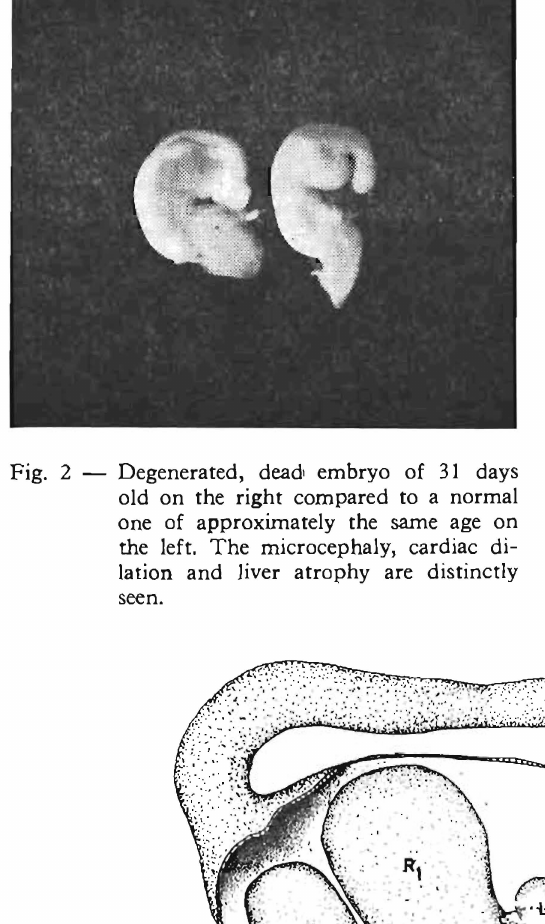
Fig. 2 - Degenerated, dead embryo of 31 days old on the right compared to a normal one of approximately the same age on the left. The microcephaly, cardiac di lation and liver atrophy are distinctly seen.